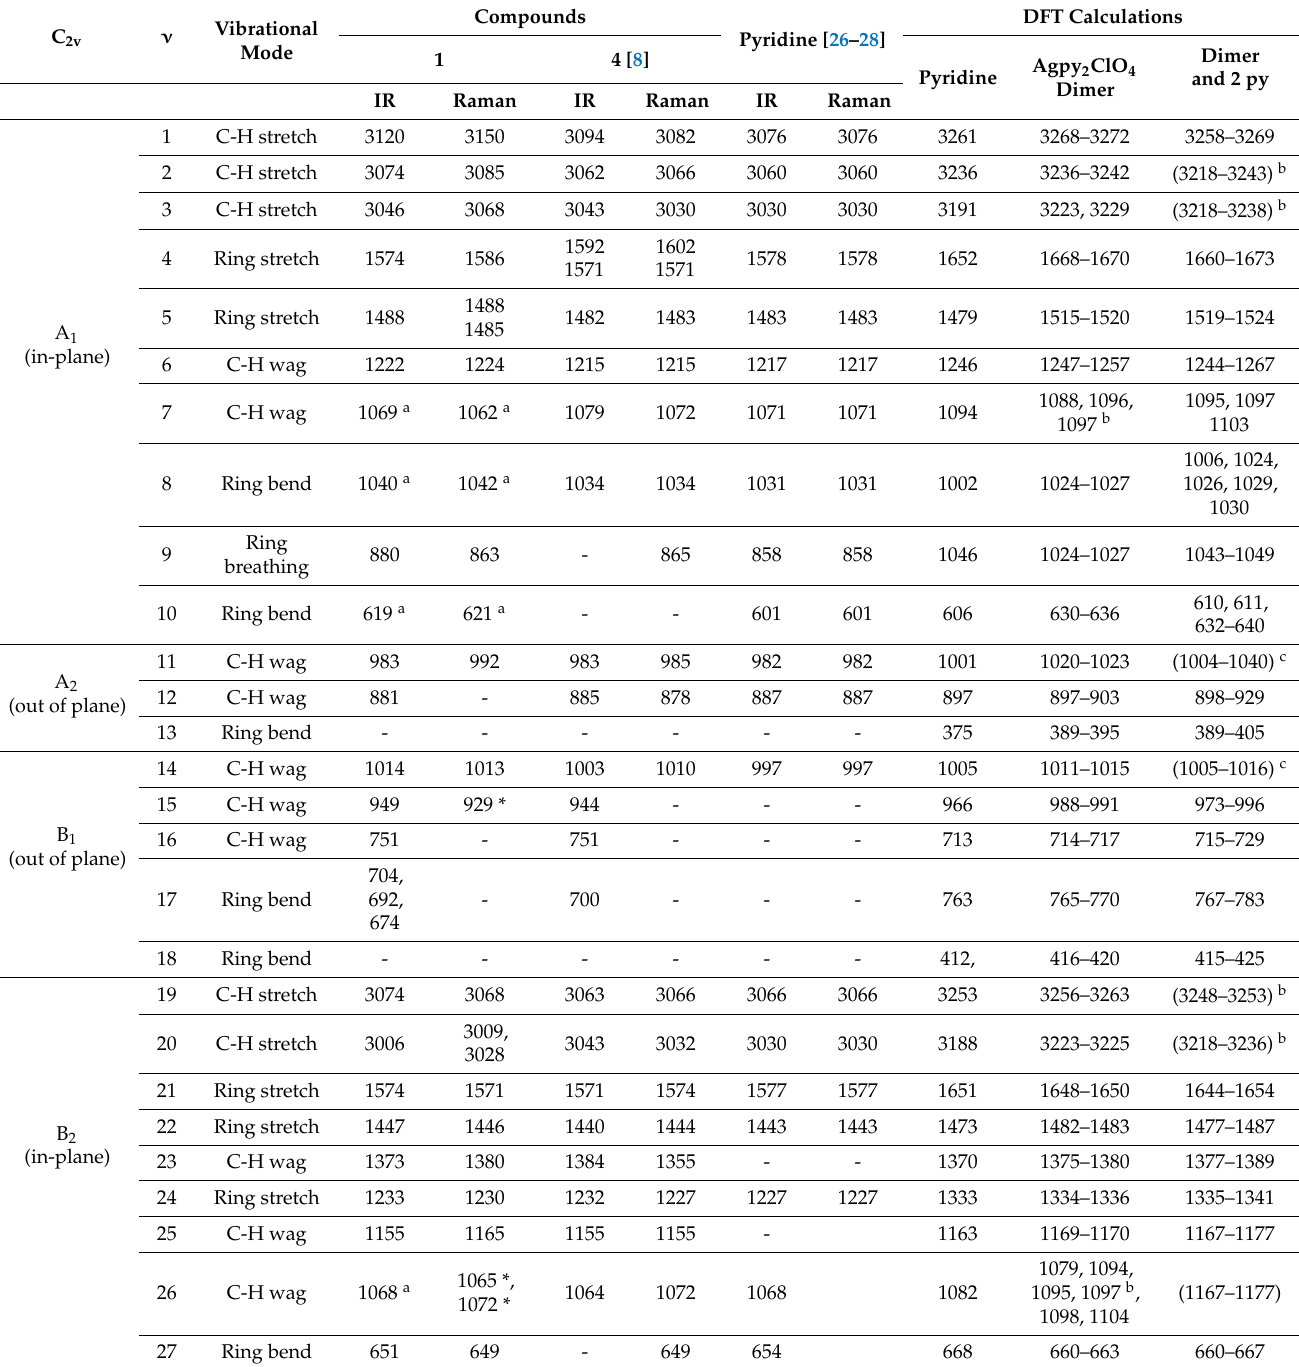
Figure 2, as well as the dimer coordinated by two py ligands at the O4 atoms, referred to a “dimer and 2 py” from here on. The geometries optimized at the M05/LANL2DZ and 6–31G(d,p) level (see the Section 3) are listed in Tables S7 and S8. In Table 3, we present the vibrational frequencies obtained for the pyridine modes. Table 3. Assignment of the pyridine normal modes in the IR and Raman spectra of compound 1 . * Overlapped with Cl-O